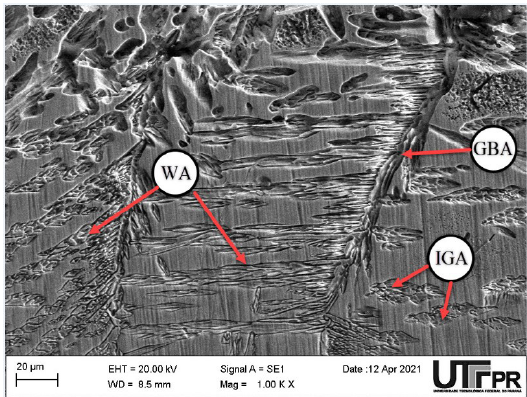
Figure 13. SEM micrograph of the preferential attack of secondary austenite in crevice corrosion tests (PD-PS-PD) generated in the weld metal in NaCl 3.5% wt.